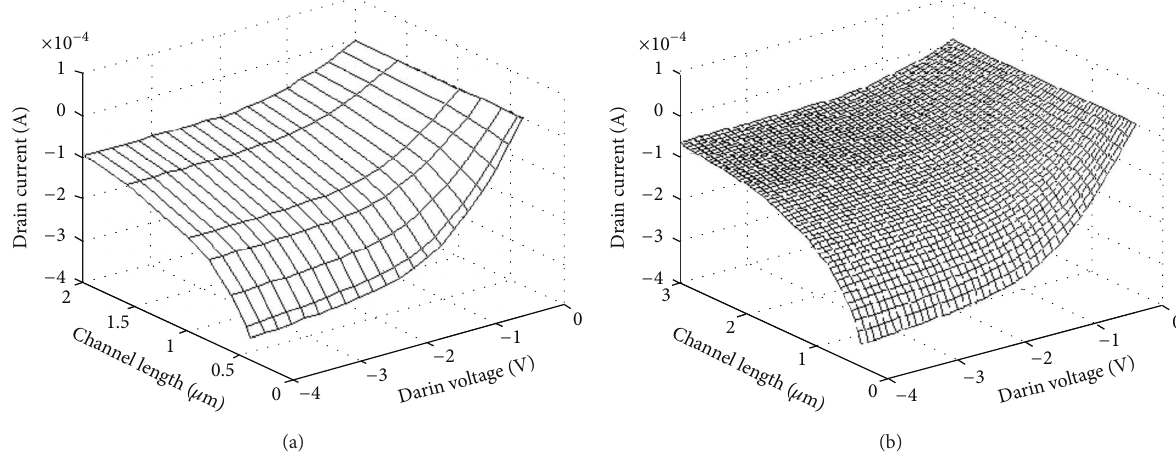
Figure 3: The 3D-like 𝐼 𝑑 (a) measurement data surface and (b) prediction data surface versus 𝐿 and 𝑉 𝑑 of the group 1A samples (as 𝑉 𝑔 = −3 V).